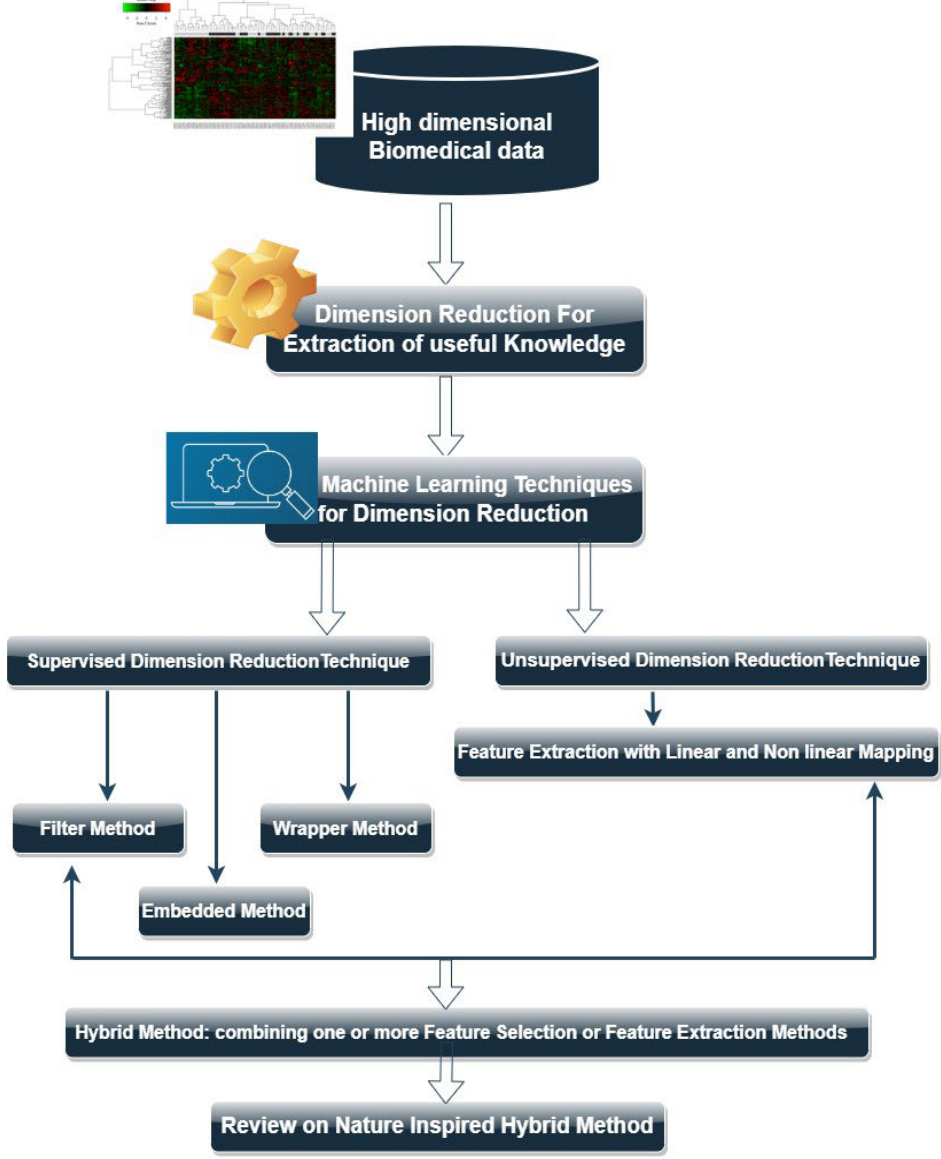
Figure 2. Taxonomy of dimension reduction algorithms for biomedical data analysis.